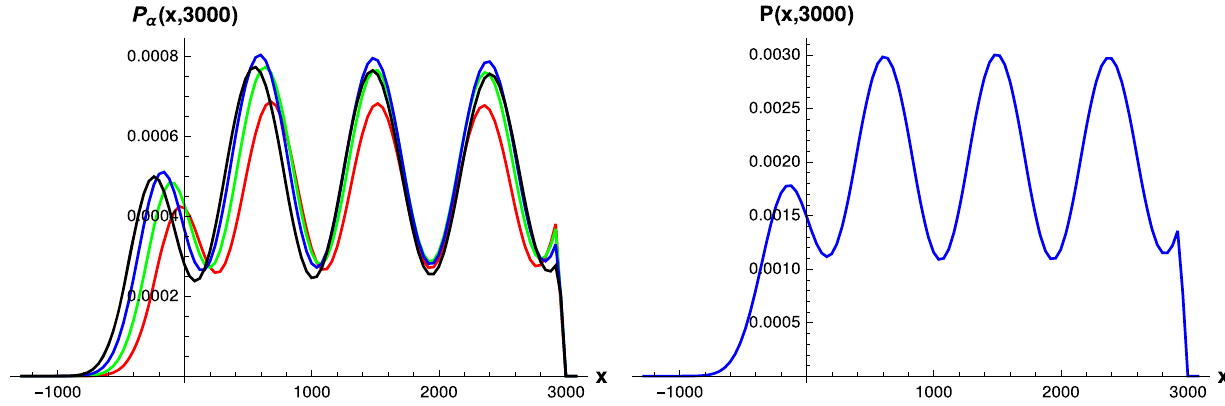
Fig. 11 The probability densities P (right) and the partial probability densities P α (left) at t = 3000. The environmental interaction energy eigenvalues, for (cid:17) H , are (cid:15) = 0 , 0 . 1 , 0 . 2 and 0 . 3 corresponding to the red, green, blue and black curves respectively. Here m 1 = 0 . 3, m 2 = 0 . 35 and σ = 0 .